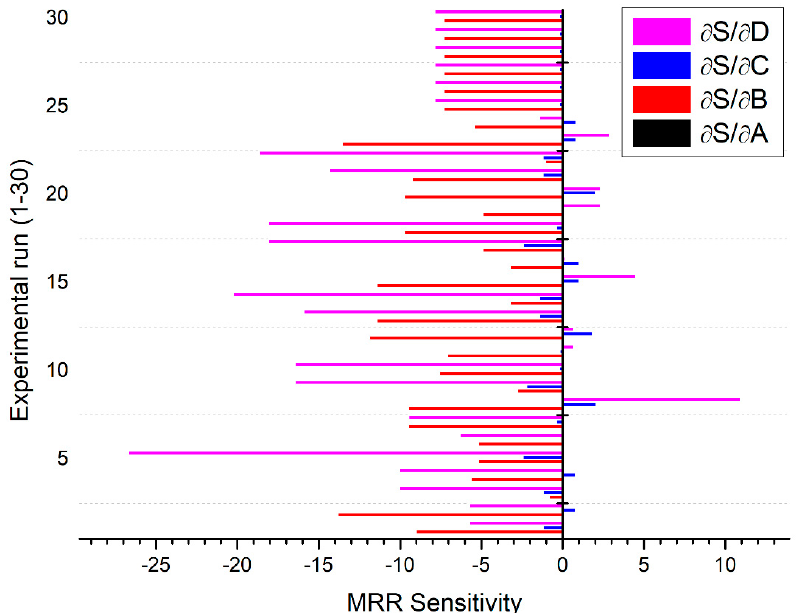
Figure 11. Sensitivity of PAC variables on MRR.